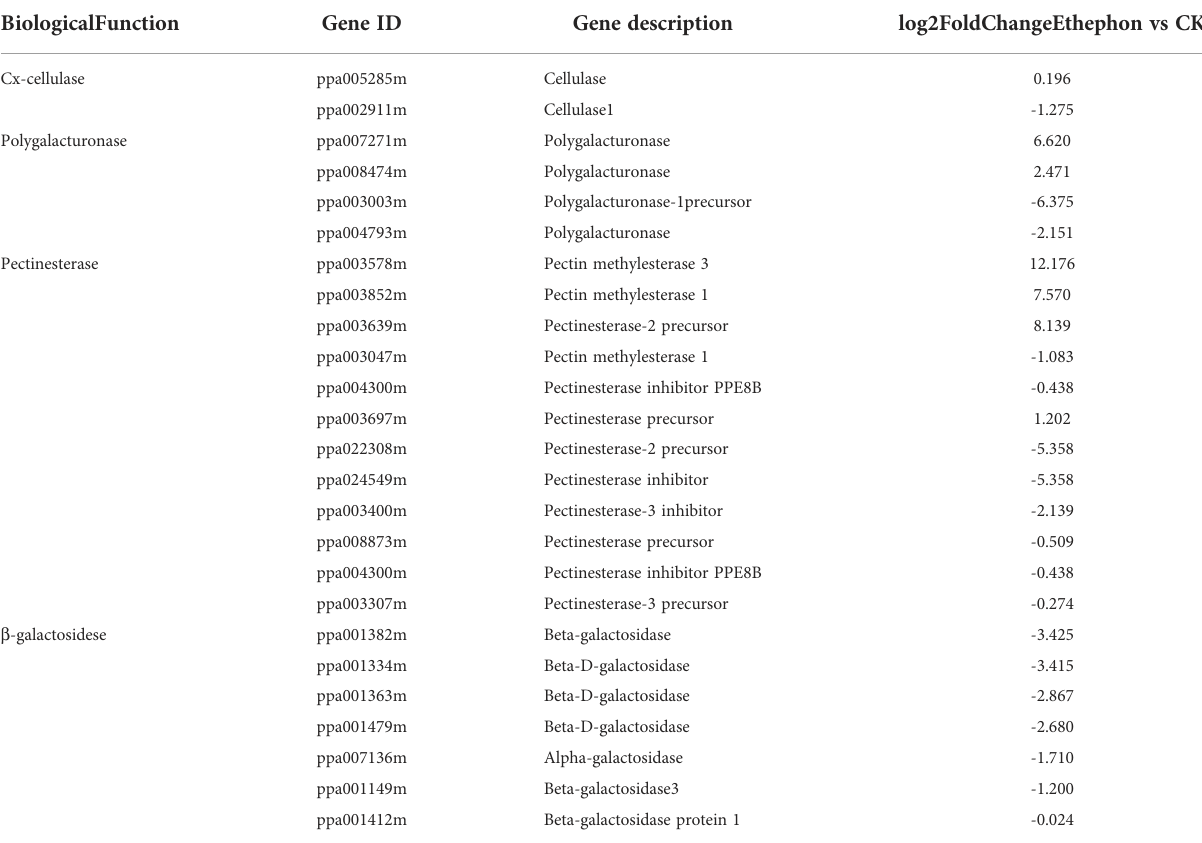
TABLE 2 DEGs involved in cell wall